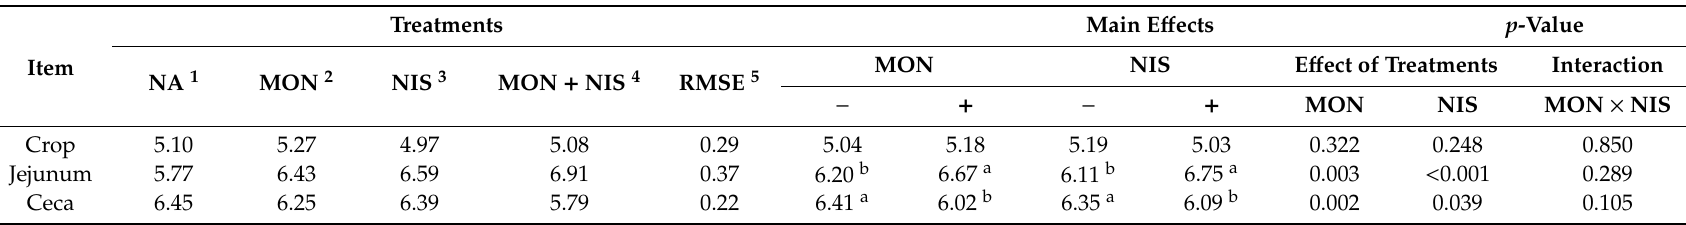
Table 4. The e ff ect of dietary supplementation of nisin alone or in combination with monensin on selected microbial populations (log CFU / g digesta) in the jejunal content determined by DAPI staining and fluorescent in situ hybridization (FISH), Experiment 1.